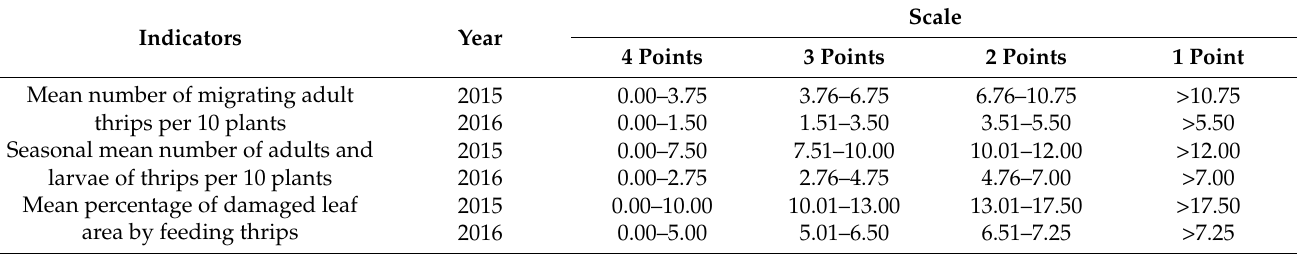
Table 1. The number of points assigned to indicators of the field resistance of onion cultivars to Thrips tabaci